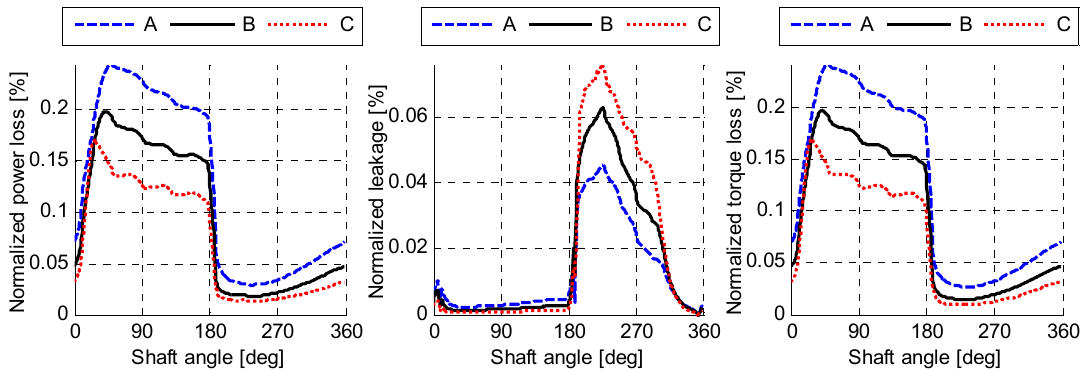
Figure 8. Normalized slipper/swashplate interface performance for different sizes.